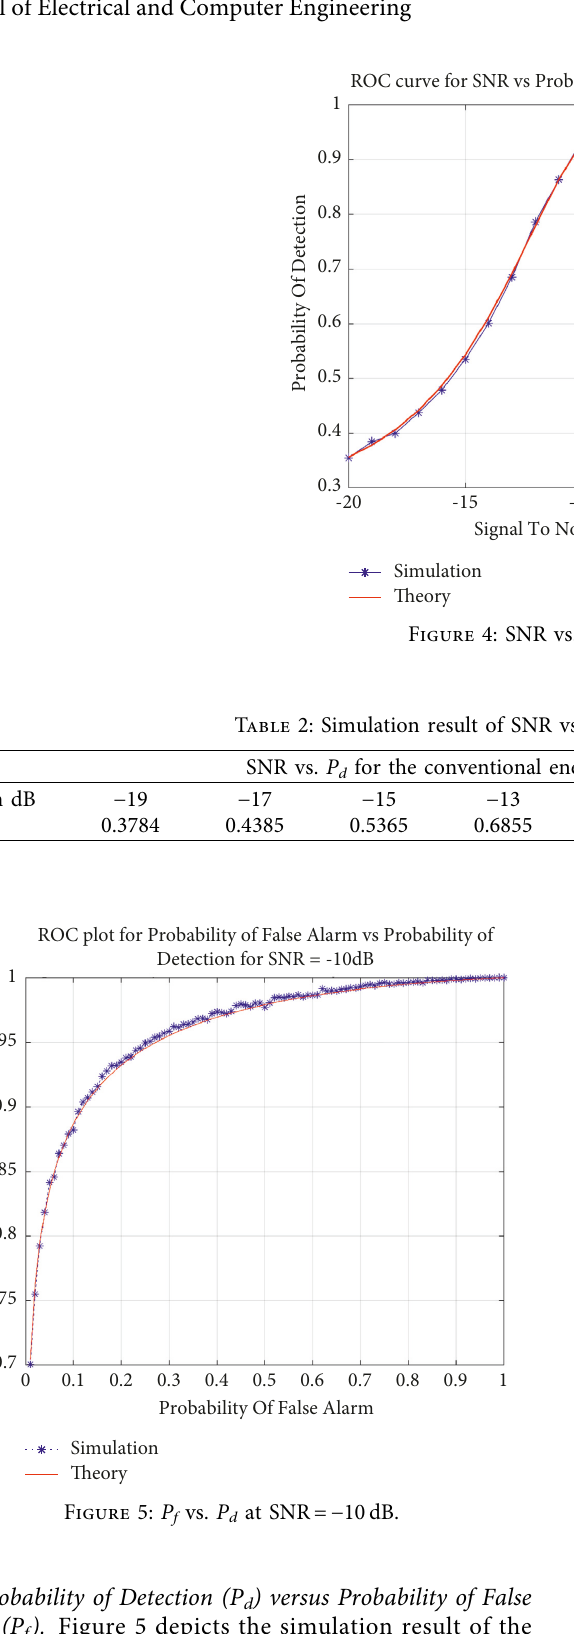
ROC curve for SNR vs Probability of Detection for Pf=0.2